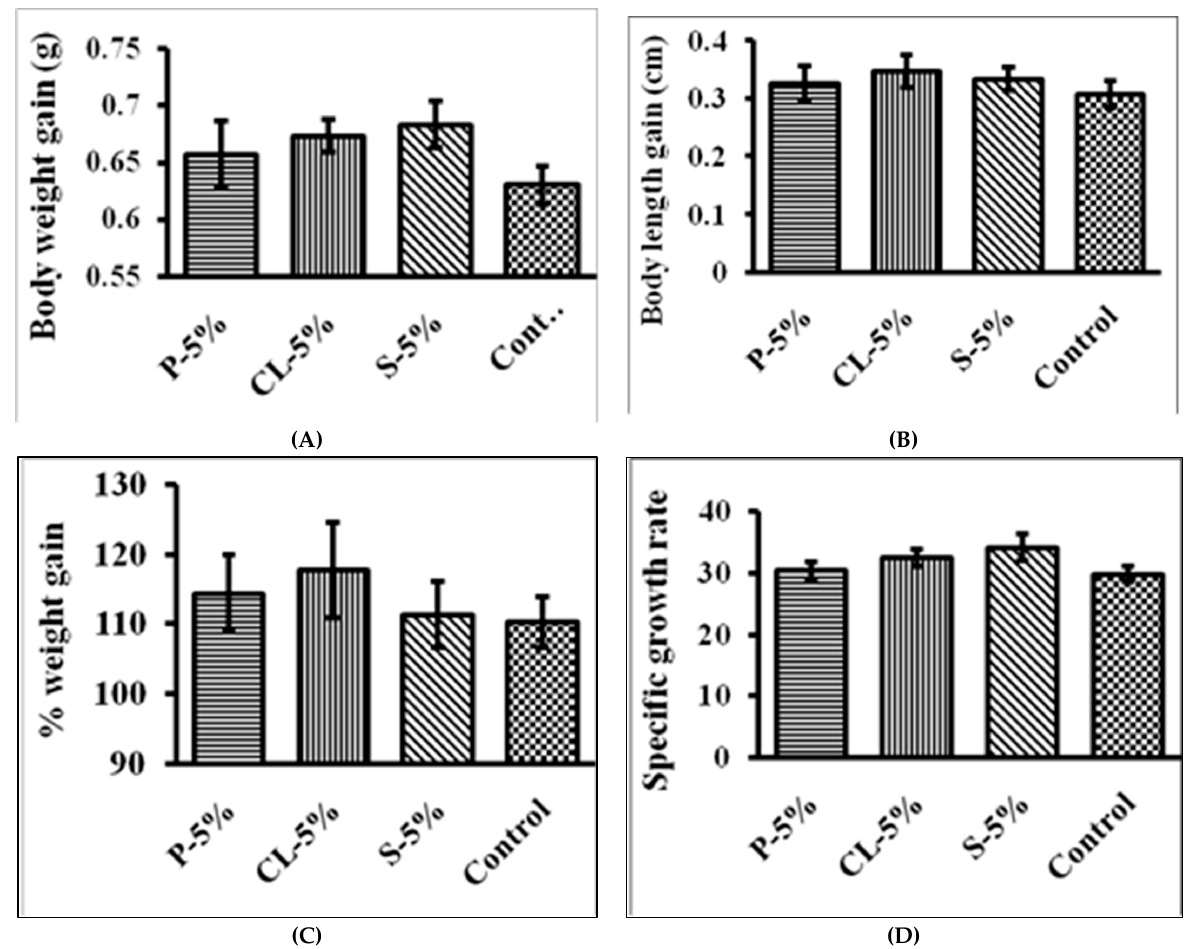
Figure 4. Growth performance of P. conchonius after 20-day feeding of gel-based feed: ( A ) body weight gain; ( B ) body length gain; ( C ) % weight gain; ( D ) specific growth rate. Data are represented as mean ± SE. Different superscripts indicate statistically significant differences ( p <0.05) among the experimental groups.